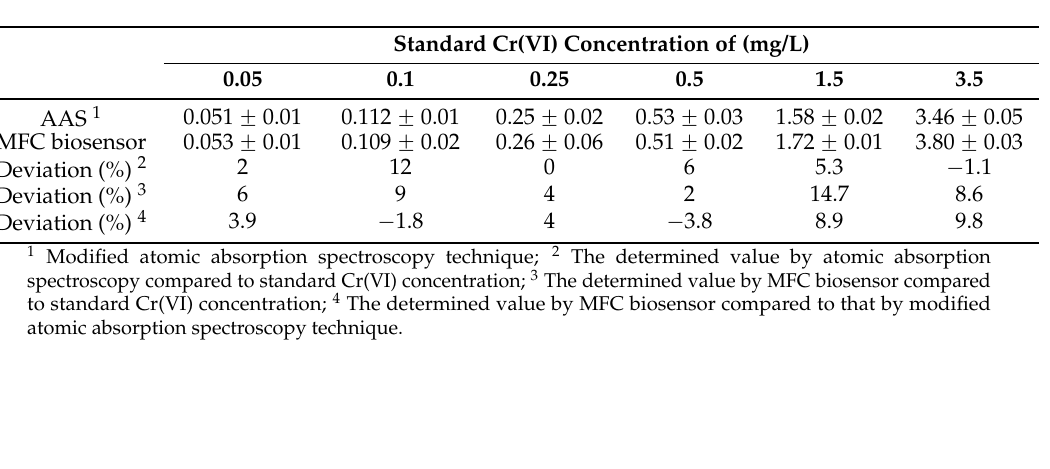
Table 1. Cr(VI) measurement from artificial wastewater by atomic absorption spectroscopy and MFC biosensor.